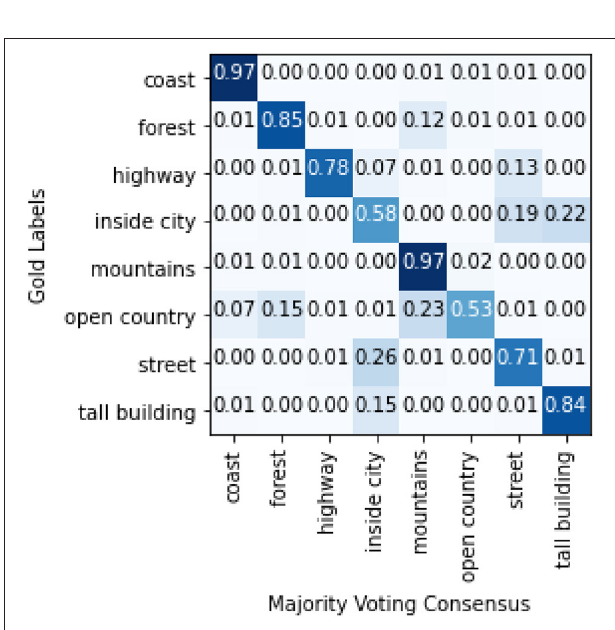
FIGURE 4 | Bar chart showing the gold label distribution of the images with the lowest temperature (images in the 1st quartile range of temperature), i.e., the lowest certainty.